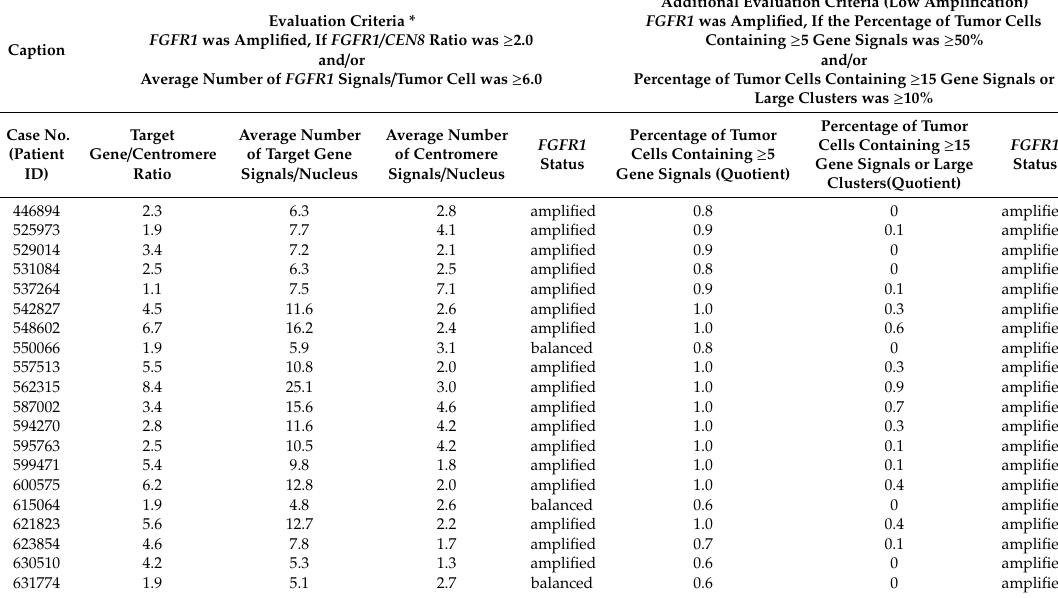
Table 2. FGFR1 amplified cases based on FISH testing of a metastatic breast cancer cohort ( n = 100). * FGFR1 amplification was based on the criteria of Schildhaus et al., 2012. Notably: FGFR1 / CEN8 ratio was ≥ 2.0, or the average number of FGFR1 signals per tumor cell nucleus was ≥ 6. Additional